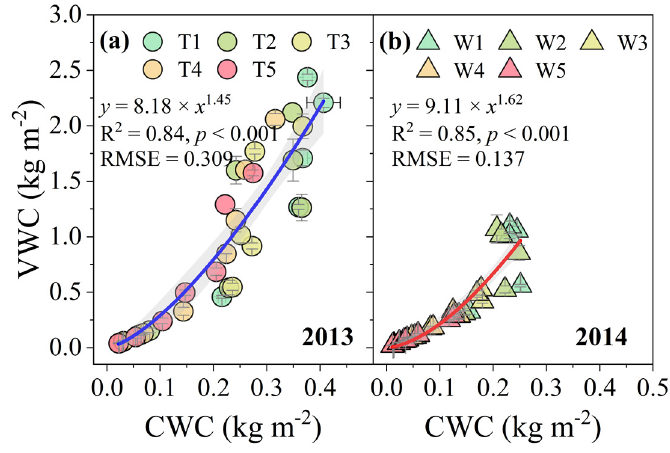
Figure 2. Connection between canopy water content (CWC) and vegetation water content (VWC) during soil drying under different irrigation treatments in the 2013 ( a ) and 2014 ( b ) growing seasons. Nonlinear regression lines show the 95% confidence intervals. Error bars denote mean ± SE.